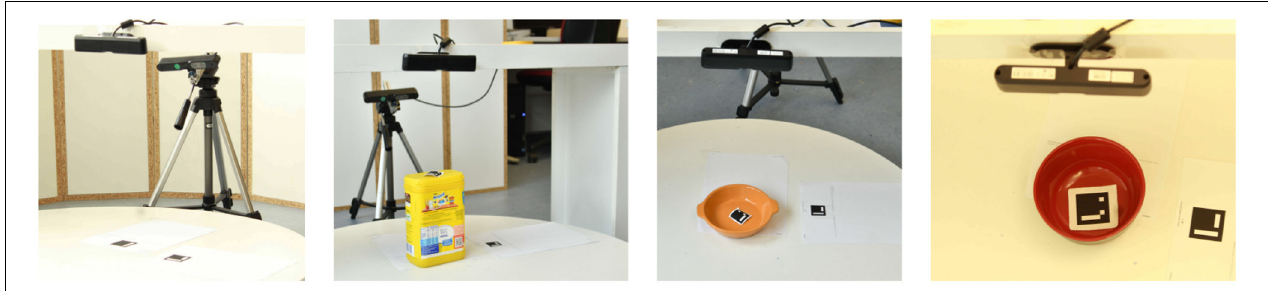
FIGURE 4 | Light-weight experimental setup consisting of two cameras and fiducial markers (Garrido-Jurado et al., 2014), for acquiring physical properties.